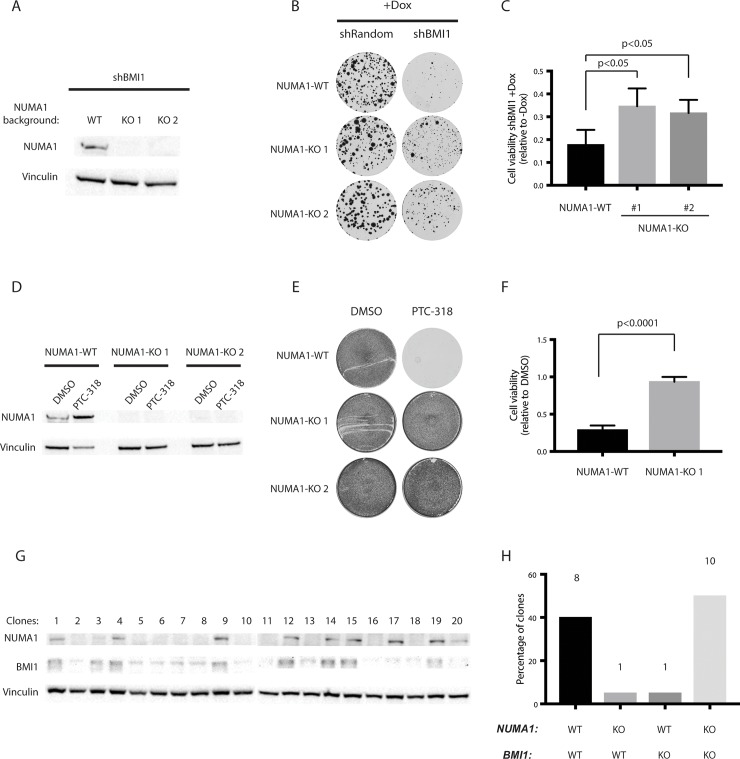
Cas9-induced NUMA1 knockout rescues HAP1 cytotoxicity caused by BMI1 inhibition.(A) Protein expression of NUMA1 in populations of HAP1 cells transduced with a doxycycline-inducible shBMI1 construct in NUMA1-WT or NUMA1-KO backgrounds (NUMA1-KO1 and NUMA1-KO2 represent two separate clones). (B and C) Survival of the HAP1 NUMA1-WT and NUMA1-KO clones transduced with the inducible shBMI1 construct and maintained with or without doxycycline (B) colony formation and (C) cell viability. (D) Expression of NUMA1 protein in HAP1 NUMA1-WT and NUMA1-KO clones treated either with 0.1% DMSO or 40 nM of PTC-318. The survival of these cells was analyzed by (E) colony formation assay and (F) cell viability. (G) Protein expression of NUMA1 and BMI1 in NUMA1-WT cells transfected with CRISPR-Cas9 targeting BMI1, single-cell sorted, and expanded (left). (H) Percentages of each genetic background based on the respective protein expression (right). Error bars represent SD (n = 3). A two-tailed Student’s t-test was performed for statistical testing.